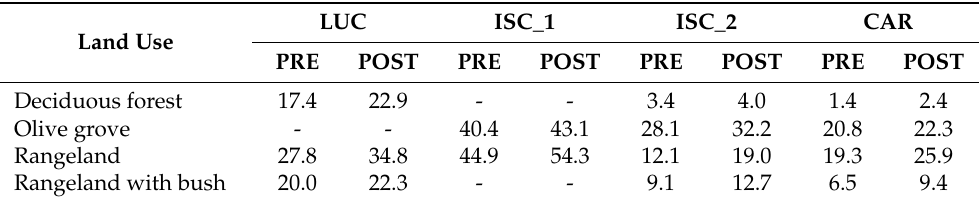
Table 5. Pre- and post-fire runoff average values (mm) per land use.